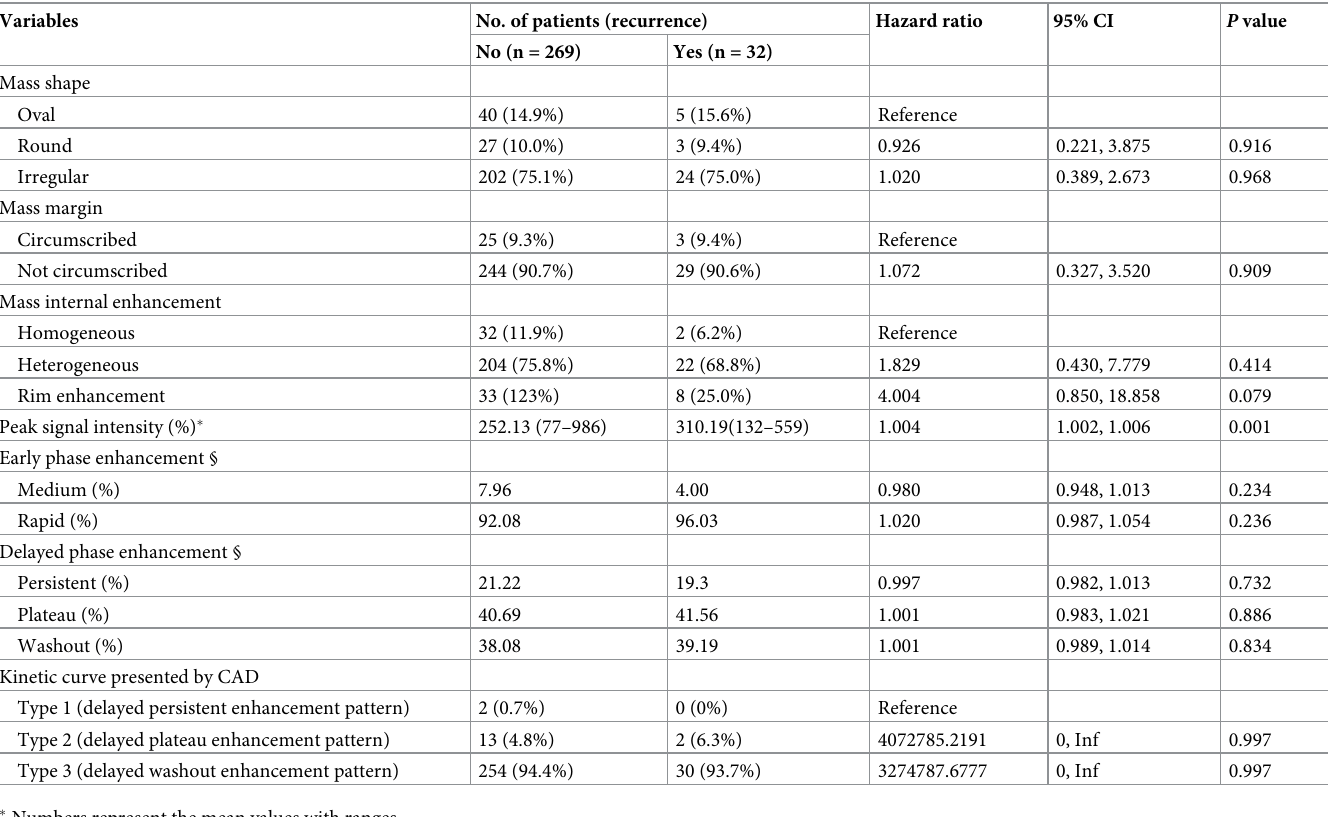
Table 2. Univariate Cox proportional hazard analysis of morphologic and kinetic features on MR imaging with survival